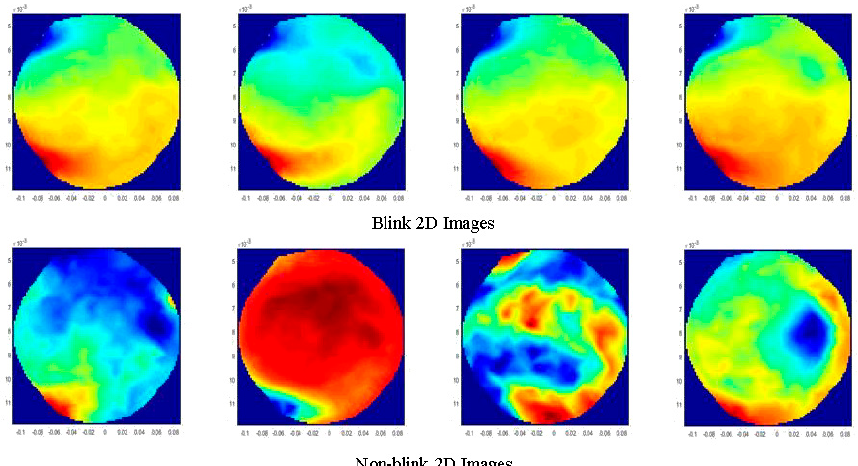
Figure 4. The spatial distribution characteristics of the blink artifacts. Four examples for the blink and non-blink 2D images, respectively.